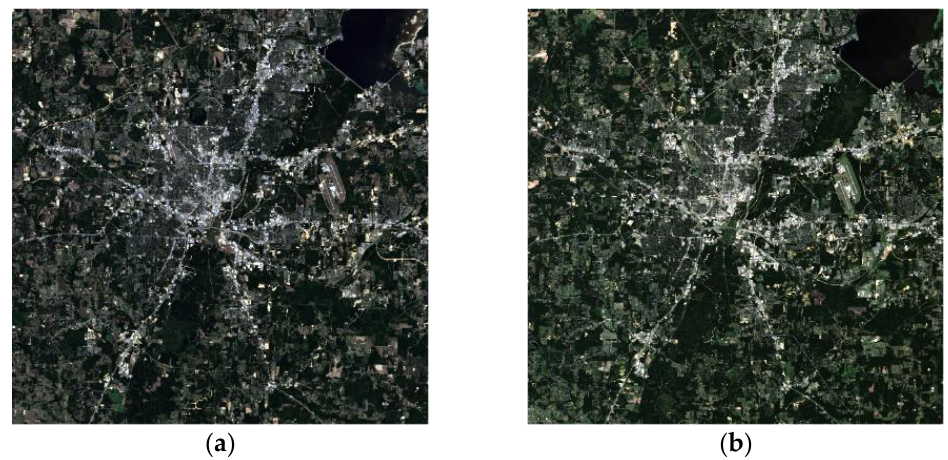
Figure 6. Landsat imagery of Jackson, Mississippi study area in true color: ( a ) 2000; ( b ) 2010.